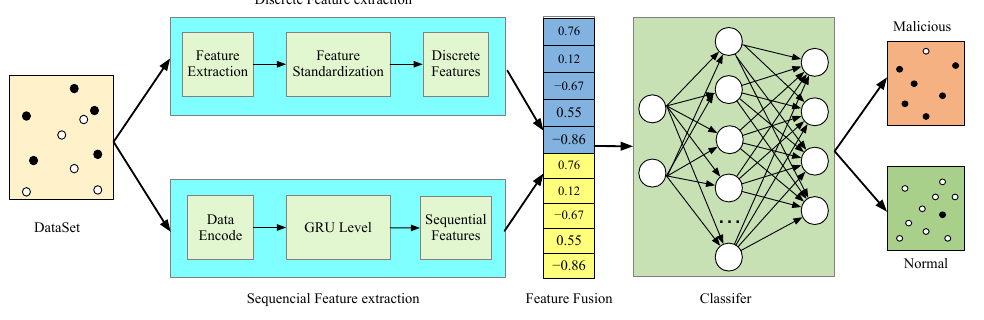
Figure 1. The architecture of